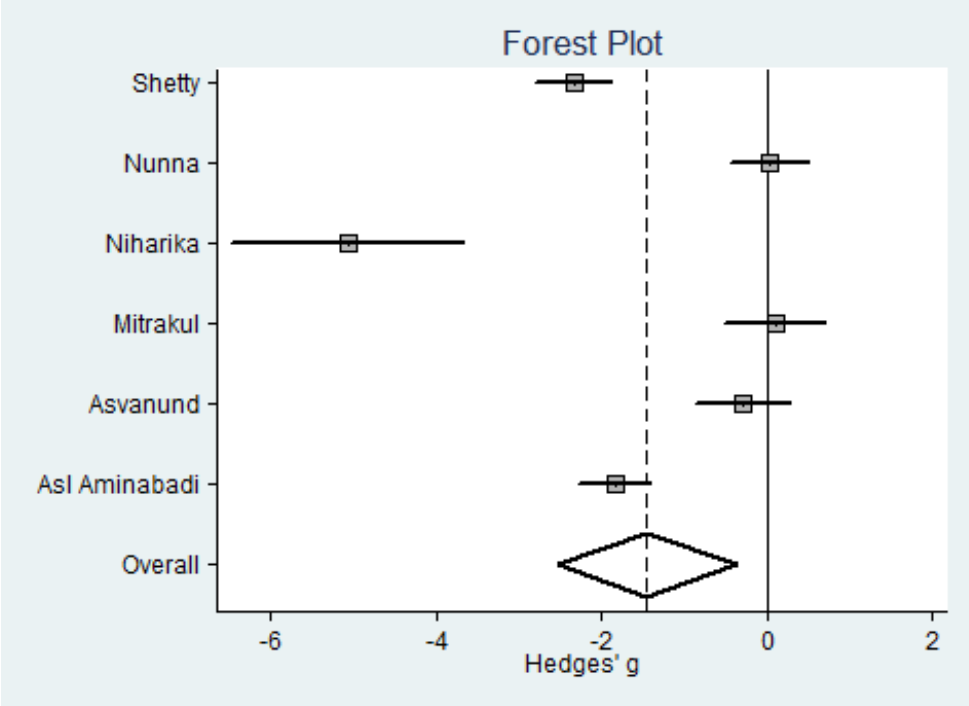
Figure 4. Forest plot for pain in children.